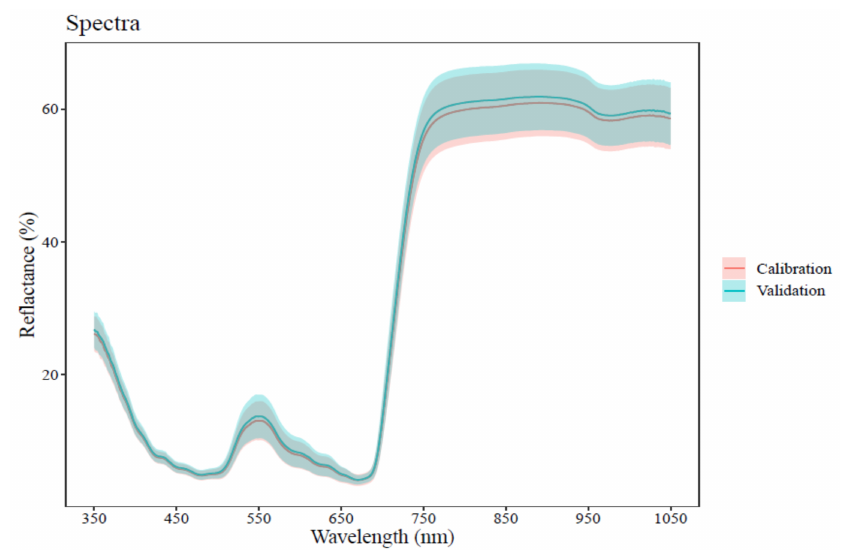
Figure 3. The average spectral reflectance with a standard deviation of the calibration and validation dataset (The continuous line is the average reflectance and the shaded area is the standard